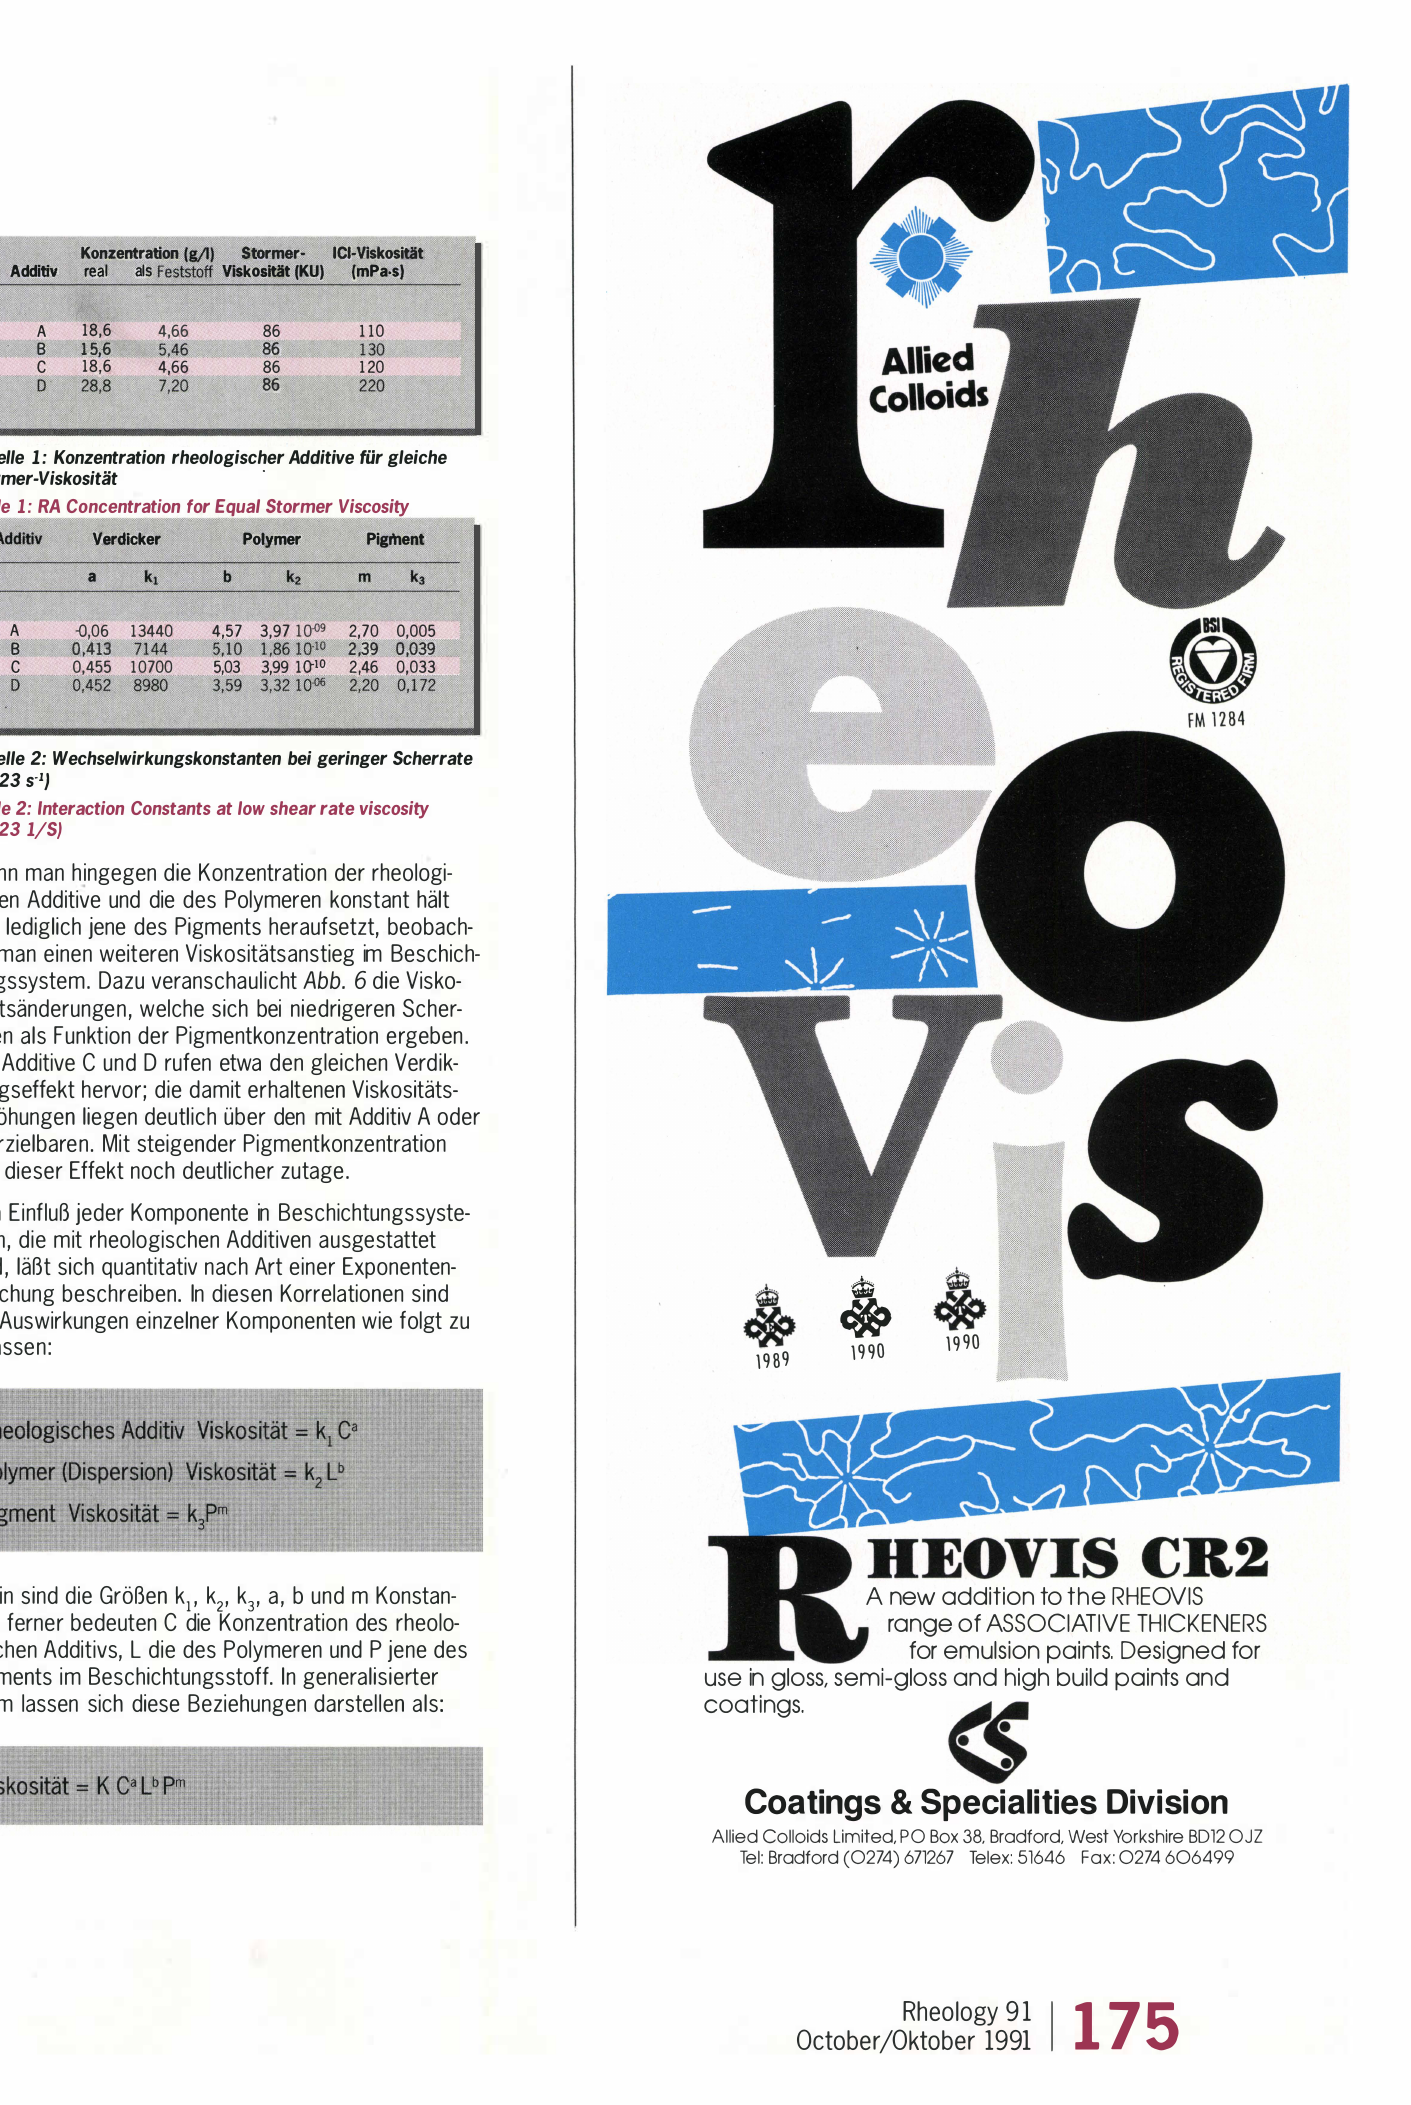
Table 1: RA Concentration for Equal Stormer Viscosity